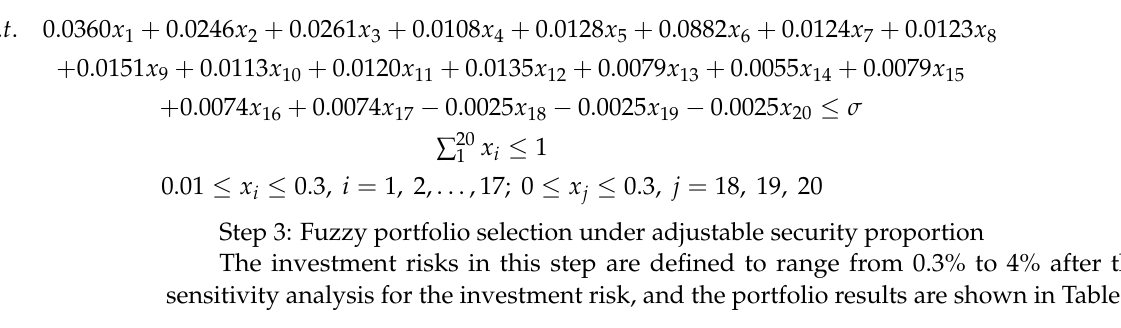
Table 6. The efficient portfolio with the guaranteed return rate (cid:101) p 1